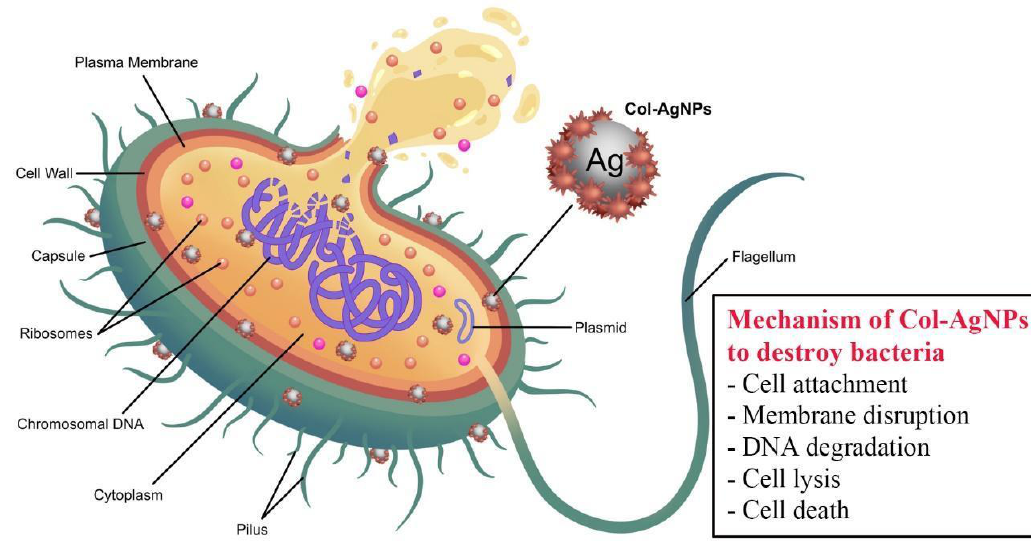
Figure 9. Proposed mechanism of Col-AgNPs against Gram-negative